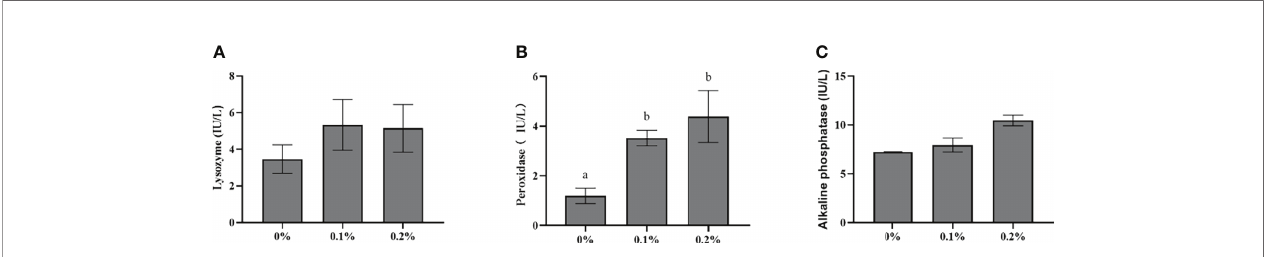
TABLE 5 | Antioxidant enzymes in serum of largemouth bass fed different experimental diets for 60 days. Items/groups